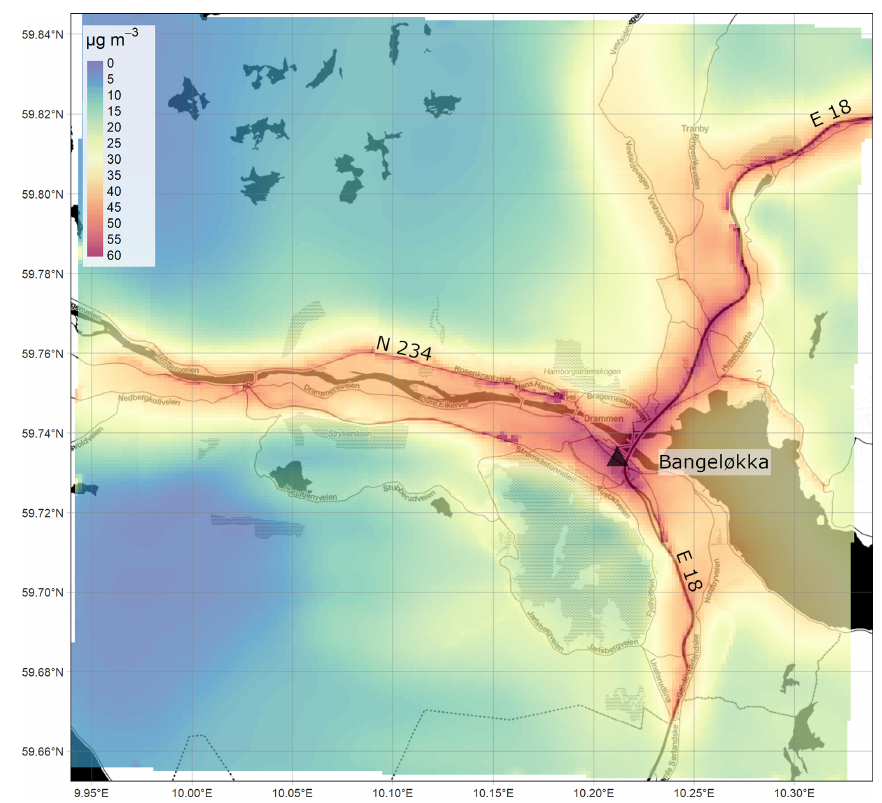
Figure 17. Simulated daily mean NO 2 concentrations for 5 January from the EPISODE model over the Drammen domain at 100m × 100m spatial resolution. This day was selected from a pollution episode lasting from 4 until 7 January. The concentrations are derived from the receptor point concentrations and then re-gridded onto a 100m grid. The colour scale shows the range in annual mean NO 2 concentrations between 0 and 60µgm − 3 . The black triangles indicate the locations of the air quality observation stations (Table 7). The dark shaded areas represent the sea, lakes, and rivers. The black lines are roads. © OpenStreetMap contributors 2019. Distributed under a Creative Commons BY-SA